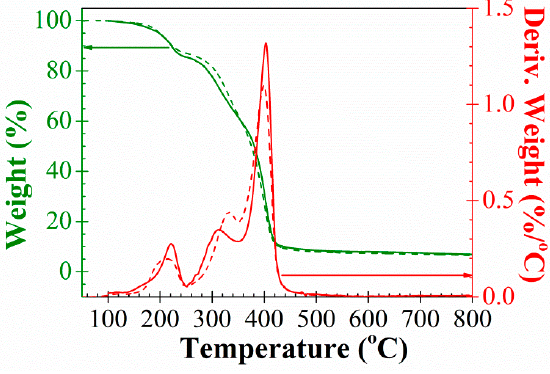
Figure 4. TGA and first derivative TGA curves of PAzMa1 (continuous line) and PAzMa2 (short dot line) samples .